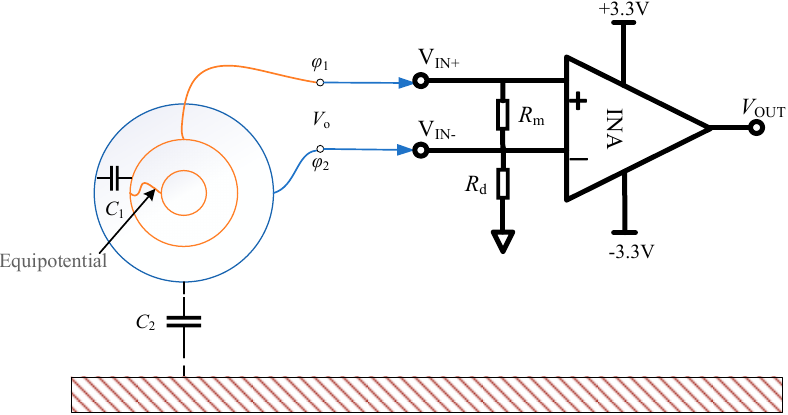
Figure 9. Differential signal processing diagram.